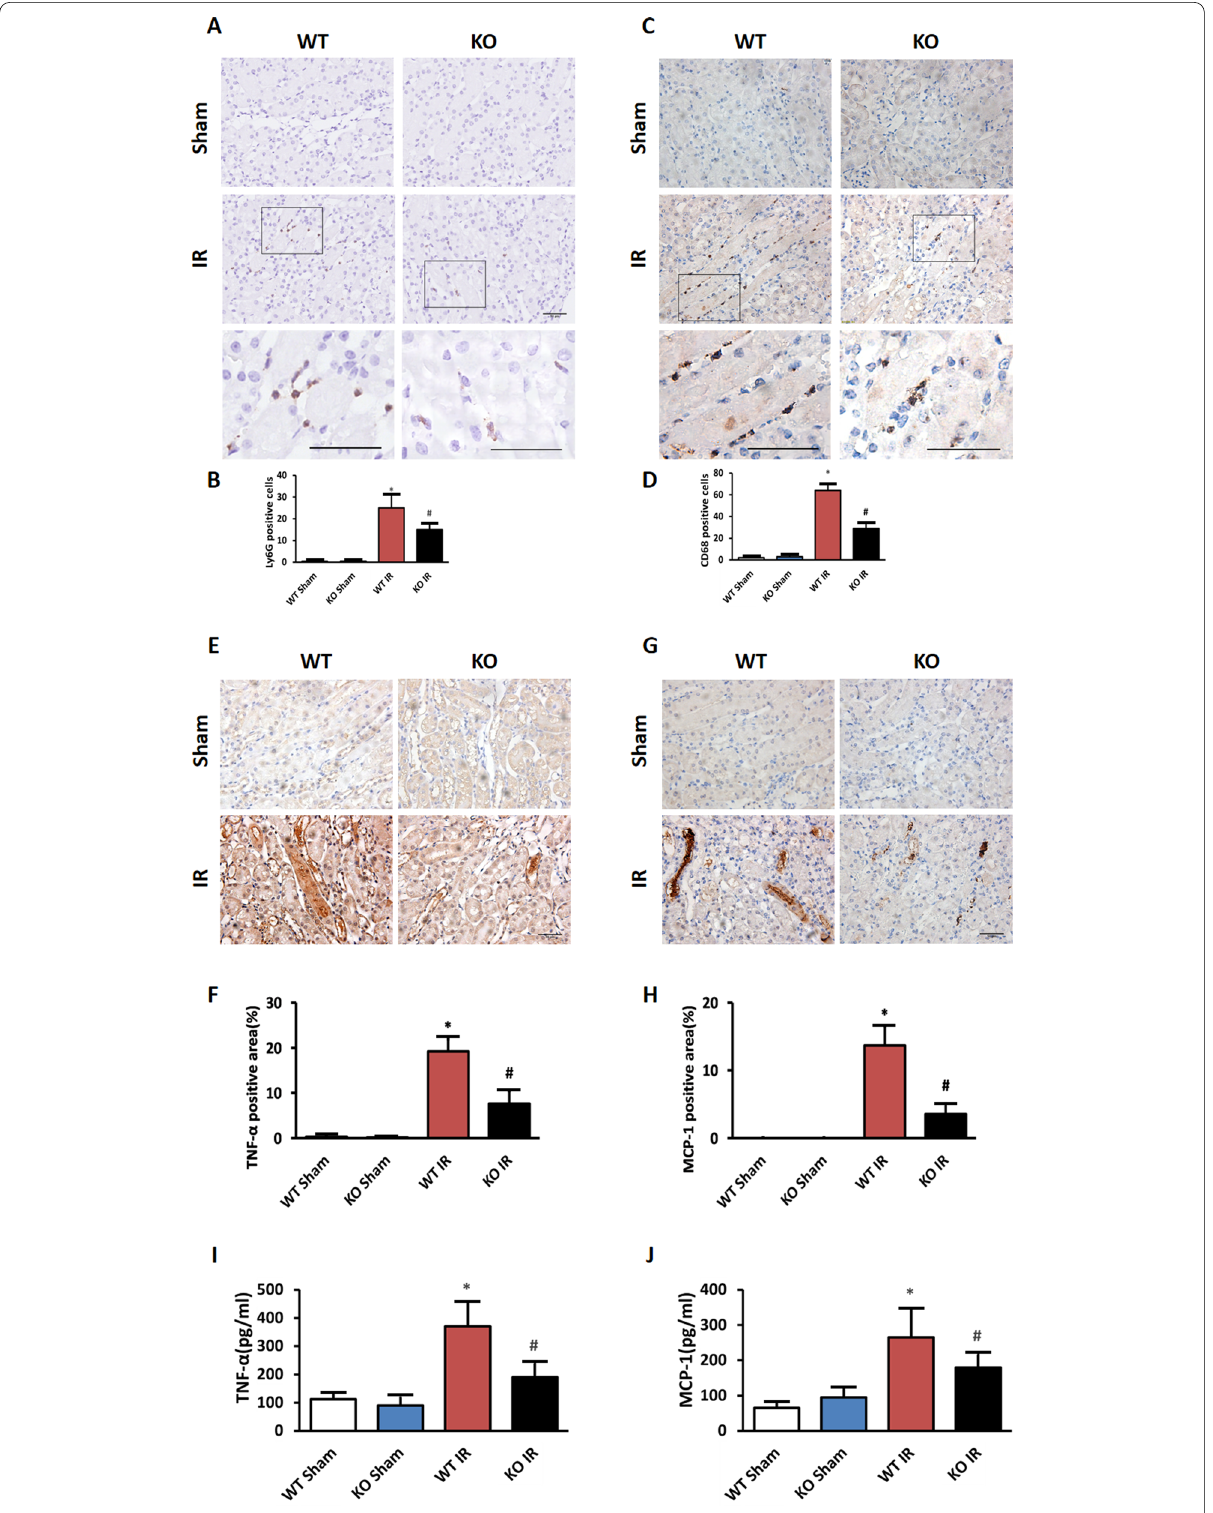
Fig. 3 (See legend on previous